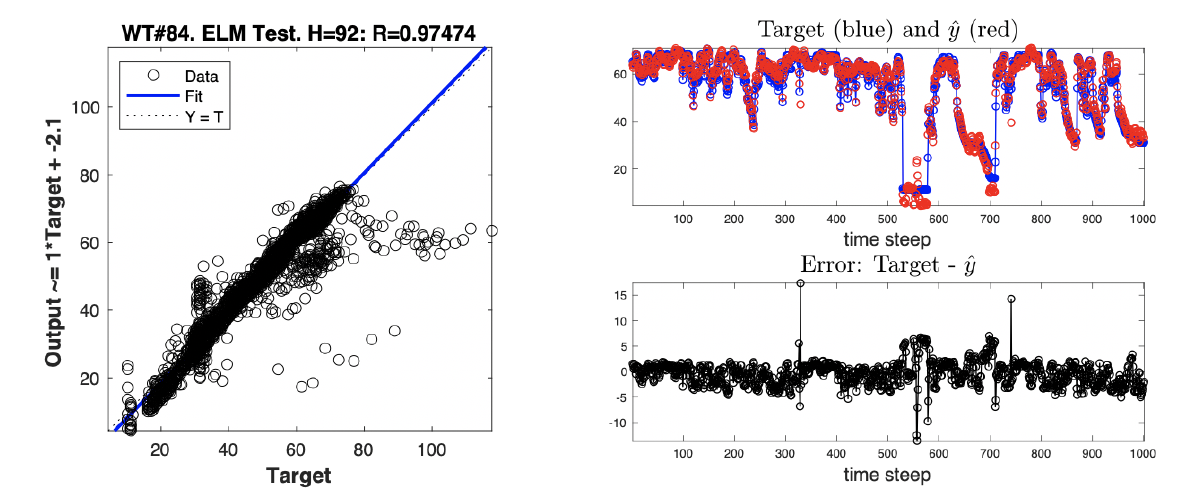
Figure 12. Test of the selected model ( H = 92) for the WT#84. ( Left ) the regression plot using all the test data. ( Right ) from a temporal window where the target ˆ y ( top ) and the error ( bottom ) can be observed in more detail.